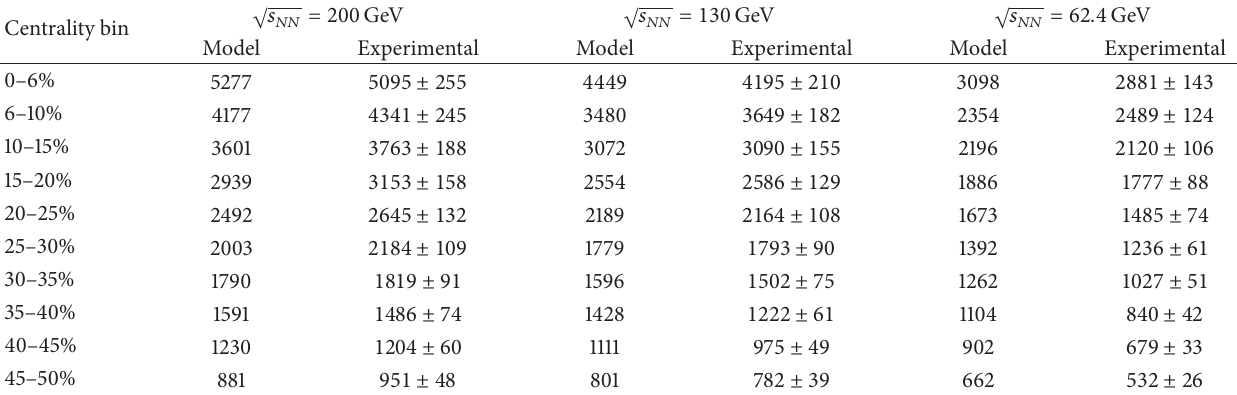
Table 1: The total charged hadron multiplicities as a function of centrality in Au-Au collisions at three different RHIC energies [41, 120]. Centrality bin